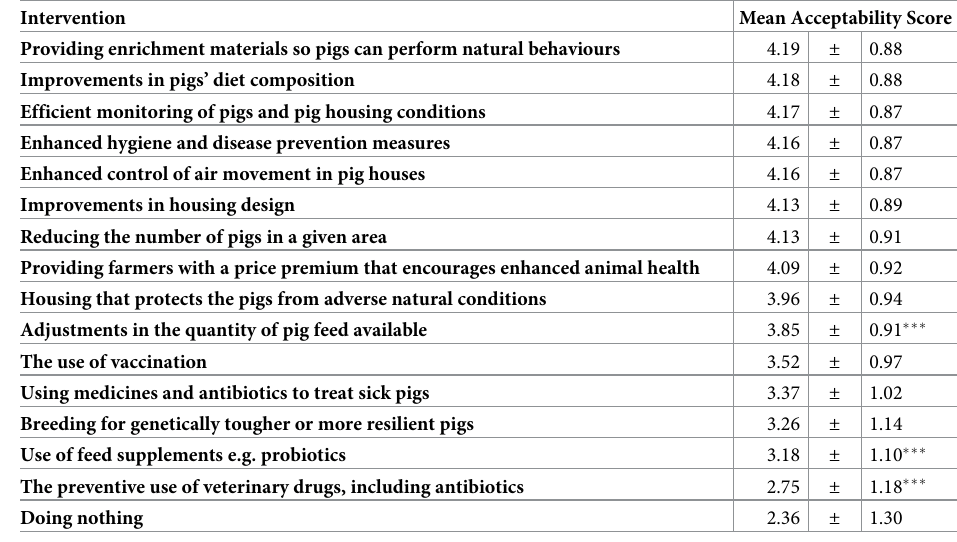
Table 7. Mean acceptability scores of interventions to control production diseases in pigs (n = 751).